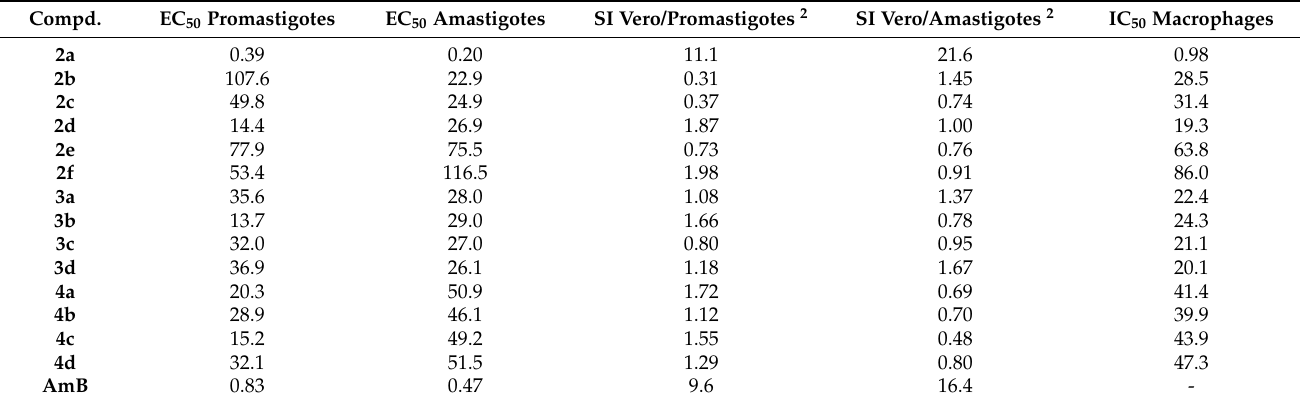
Table 2. Effective concentrations EC 50 (in µ M for promastigotes and amastigotes of Leishmania major after 72 h) and inhibitory concentration IC 50 (in µ M for macrophages) of indicated test compounds. 1 Amphotericin B (AmB) was applied as a positive